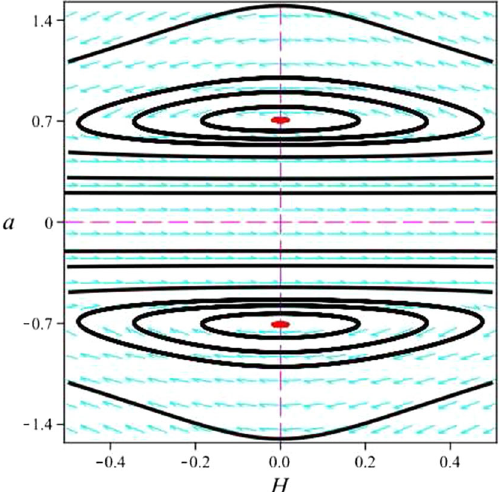
Fig. 8 Phase space of the dynamical system for the case of k = 1 ,α = 0 . 001 ,β = 0.Thedynamicalbehaviorofthescalefactorforanarbitrary trajectory of phase space (red trajectory) has been plotted